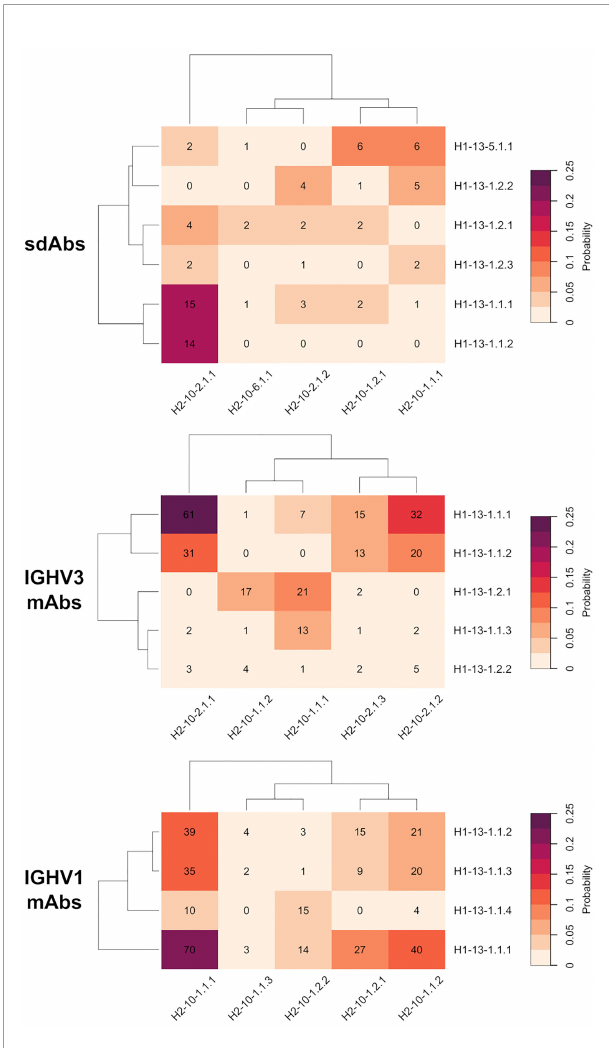
FIGURE 4 | Probability heatmap of all combinations of major clusters of CDR-H1 against major clusters of CDR-H2 for the antibody classes under study: sdAbs, IGHV3 mAbs and IGHV1 mAbs. The probability scale displayed uses the following color scheme: from beige (not probable) to purple (probable). The probabilities are scaled to the total number of major cluster representatives. The number of representatives per combination is displayed in each